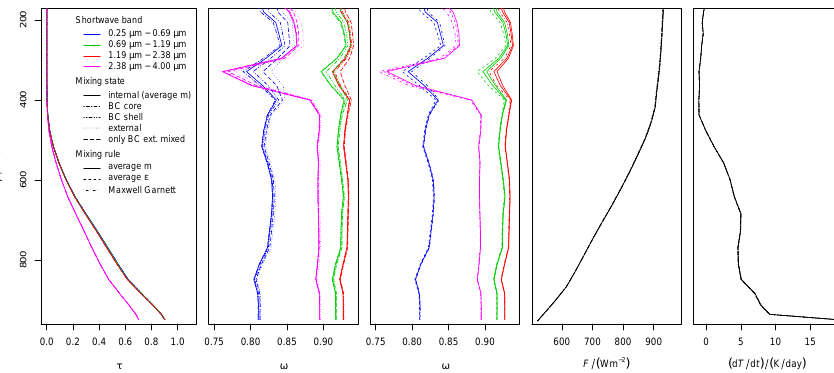
Figure 10. Column model results over the Sahara. From left to right: aerosol optical depth τ , single-scattering albedo ω , single-scattering albedo (alternative mixing rules), net shortwave flux F , temperature tendency d T/ d t . The temperature tendency takes the terrestrial bands into account. In this example, the mixing-state sensitivity is small so that the flux profiles and the temperature tendencies for the different mixing states